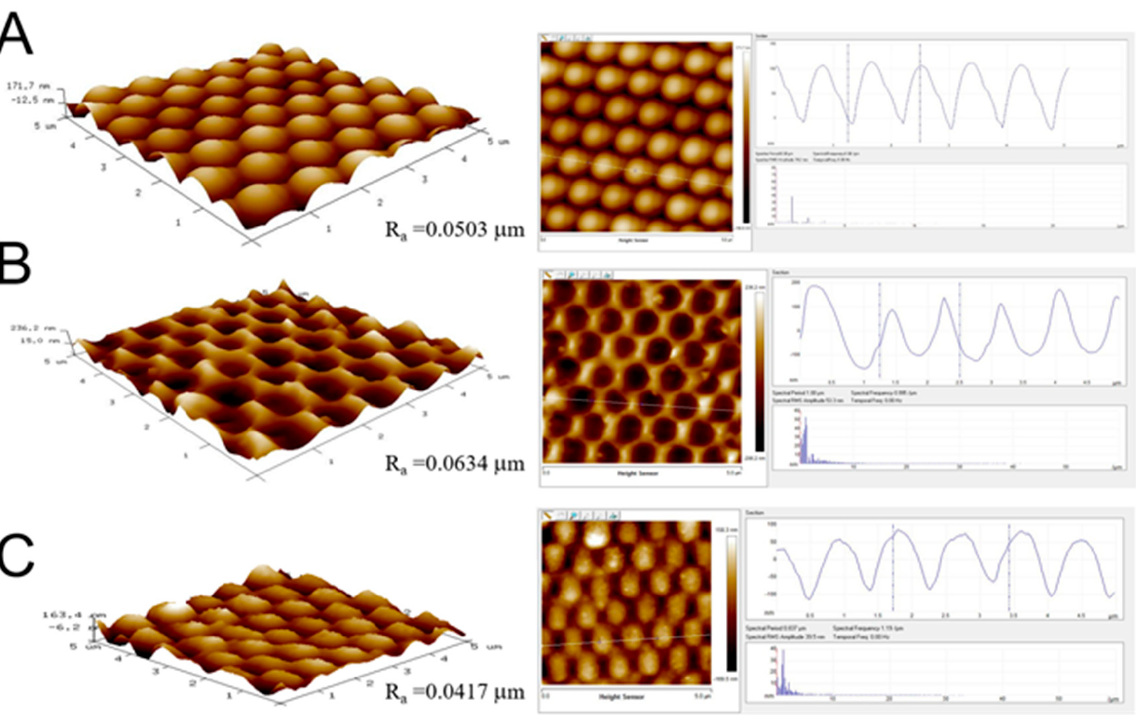
Figure 8. AFM surface profiles of ( A ) an assembled 900 nm nanosphere array, ( B ) a replicated soft mold, and ( C ) anembossed nanofeatured